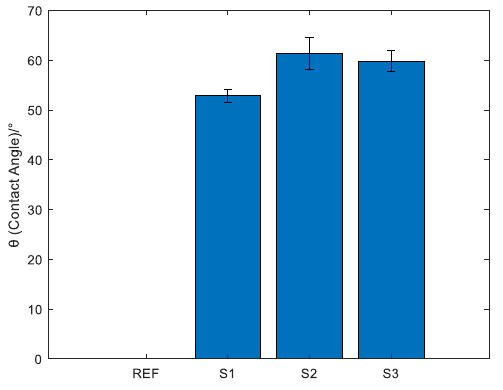
Figure 4. Water contact angle numeric measurements for the analyzed samples.